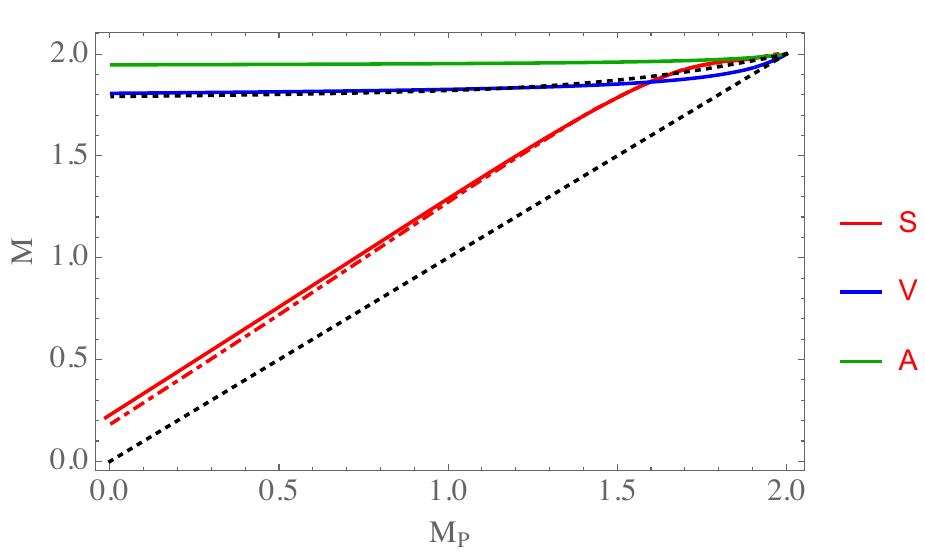
Figure 4 . The scalar, vector and axial-vector masses as a function of the pseudoscalar mass with the kernel K ( p; q ; m tot ) and m tot = 1. Changing to the very high cuto(cid:11) gives the dot-dashed line. The upper and lower dotted lines are the spin 1 and spin 0 results when the kernel K ( p; q ; 0) is used.